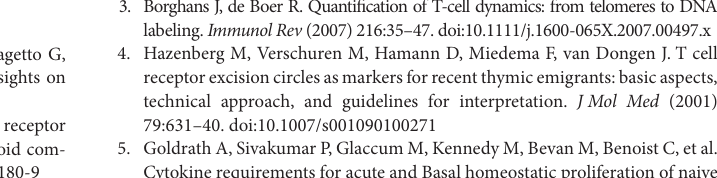
FigUre s1 | Zfx(fl/y) CD4-Cre mice progress normally through the stages of T cell development. (a) Developing T cell populations in the thymus. Shown are FACS profiles of thymocytes in control and conditional knockout mice; numbers represent the percentage of each population and are representative of over five experiments. (B) Distribution of thymocyte populations. Shown are absolute numbers ± SEM of various thymocyte populations based on expression of CD4 and CD8 as detected by flow cytometry; DP, double positive. Data are representative of two to five mice. (c) Distribution of thymocyte populations. Shown are absolute numbers ± SEM of various thymocyte populations based on expression of CD4 and CD8 as detected by flow cytometry. DN, double negative. Data are representative of two to five mice. FigUre s2 | Zfx-deficient T cells have normal response to IL-7 and display normal levels of apoptosis in vitro . (a) In vitro expansion of T cells in response to IL-7. CD62L + naïve T cells were isolated and maintained in 1 ng/mL IL-7 for 6 days. Shown is the fold expansion of control and conditional knockout (CKO) cells on days 3 and 6, for CD4 + (left) and CD8 + cells (right). Data are representative of more than three independent experiments. (B) In vitro apoptosis. Control and CKO splenic T cells were isolated and maintained in culture for 6 and 24 h, after which, they were stained for Annexin-V and 7-AAD. Numbers represent the percentage of early (Ann-V + 7-AAD − ) and late (Ann-V + 7-AAD + ) apoptotic cells; data are representative of two independent experiments. FigUre s3 | Zfx deficiency has minimal effect on stimulation of B cell antibody production. Zfx-deficient T cells can drive B cell antibody production in vivo . Control (open triangles) and conditional knockout (CKO) (CD4-Cre Zfx flox/y ; closed circles) mice were immunized with NP-keyhole limpet hemocyanin (KLH) and antibody titers were measured by ELISA every week post-immunization, for 7 weeks. Mice were boosted with a second dose of NP-KLH on day 42. Shown are relative antibody titers from five control and five CKO mice. FigUre s4 | Zfx-deficient T cells simulated in vitro display similar expression defects as unstimulated T cells as well as hematopoietic stem cells. Summary of the RNA-seq results. Volcano plot representation of differential expression analysis of genes in the control versus Zfx conditional knockout T cells. Red and blue points mark the genes with significantly increased or decreased expression, respectively, in control compared to Zfx-null samples. The x -axis shows log 2 fold-changes in expression and the y-axis the adjusted